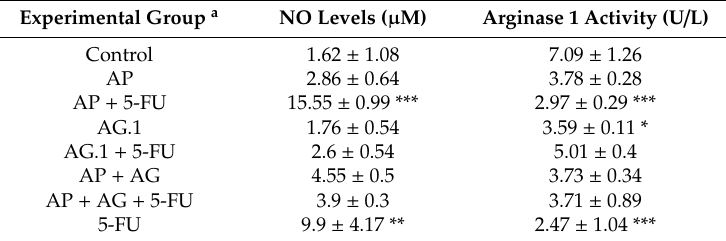
Table 4. Production of nitric oxide (NO) and arginase 1 activity in supernatant of spleen macrophages from mice bearing CT26.WT tumors.